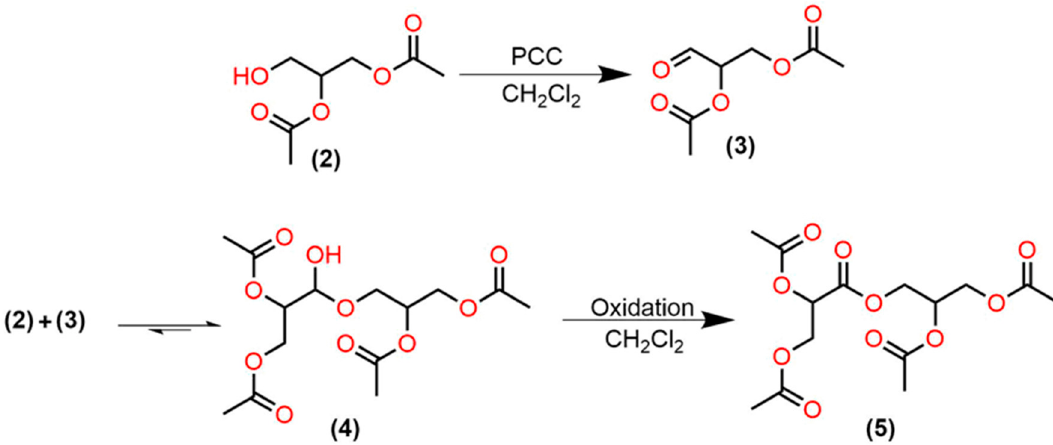
Figure 3. 1,2-diacetin (2) oxidation and dimeric ester (5) formation; (3) glyceraldehyde diacetate, (4) dimeric hemiacetal. Table 2. E ff ects of the reagent and solvent / PCC ratio on 1,2-diacetin oxidation